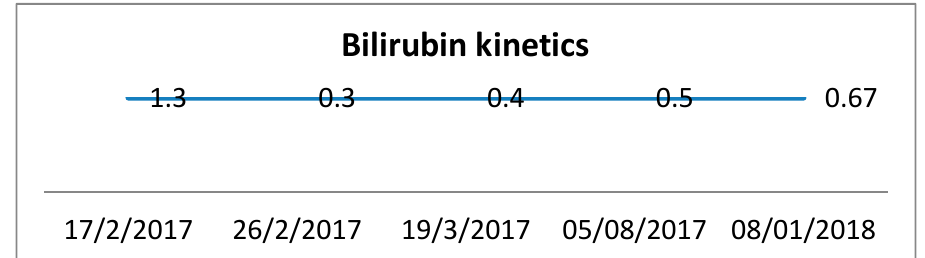
Figure 2. Bilirubin kinetics from the moment that the patient was hospitalized, several points after and 11 months after hospitalization.